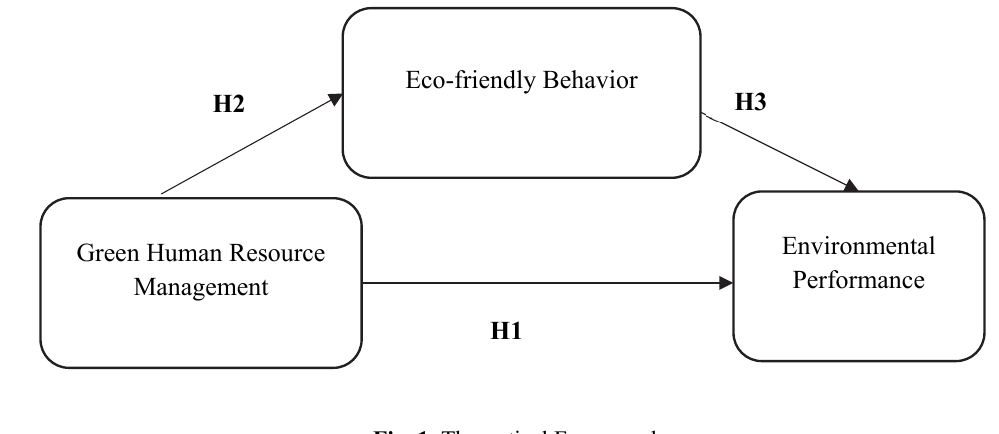
Fig. 1. Theoretical